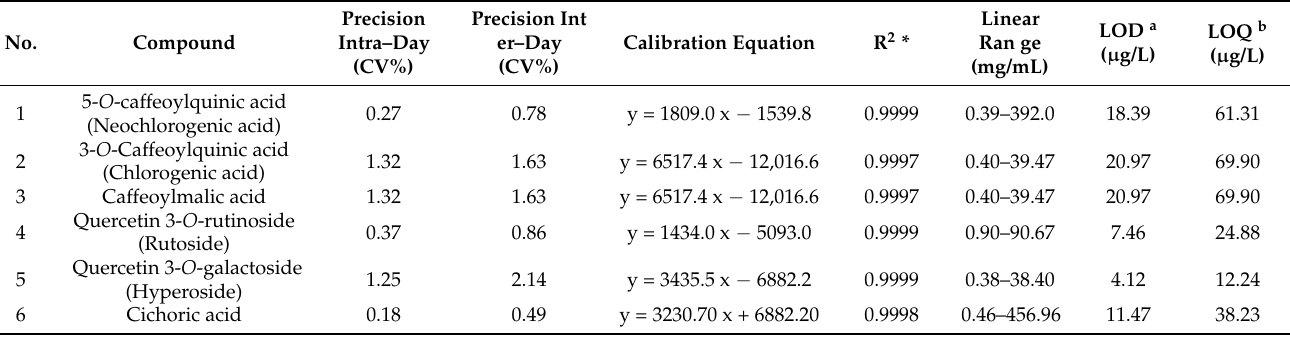
Table 7. HPLC–DAD validation